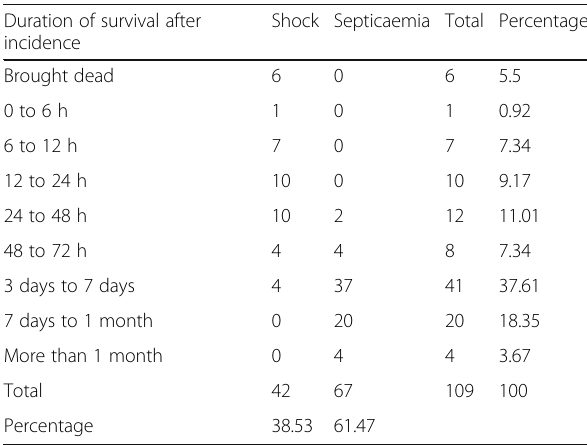
Table 3 Distribution of cases as per causes of death and survival period Duration of survival after